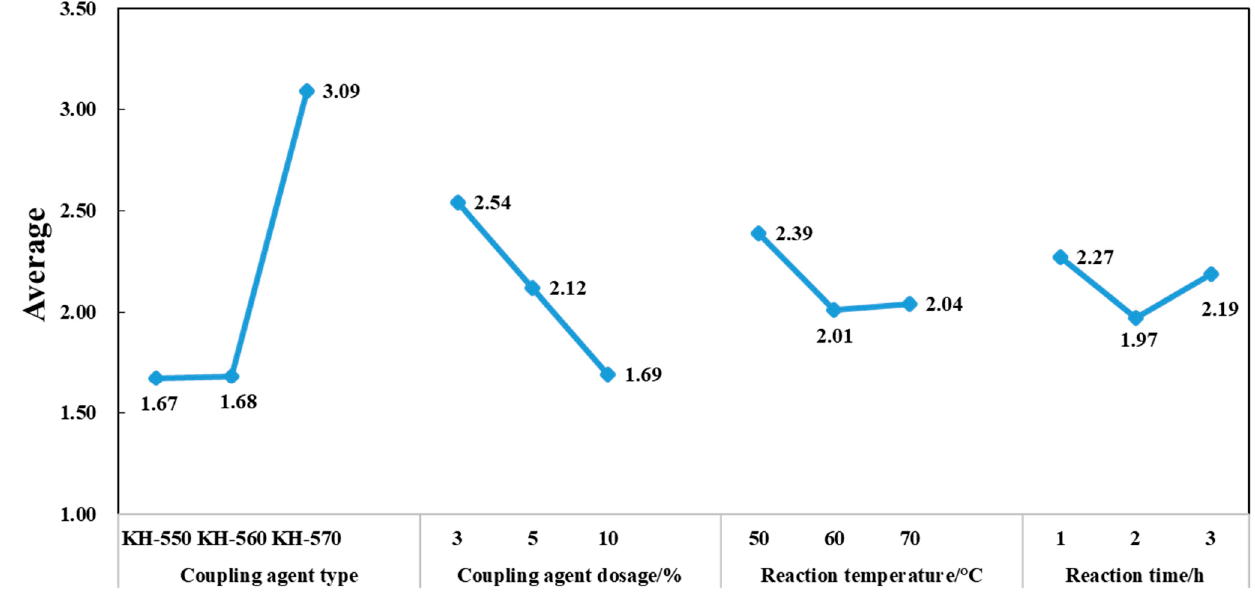
Figure 1. Factor water mean trend graph.